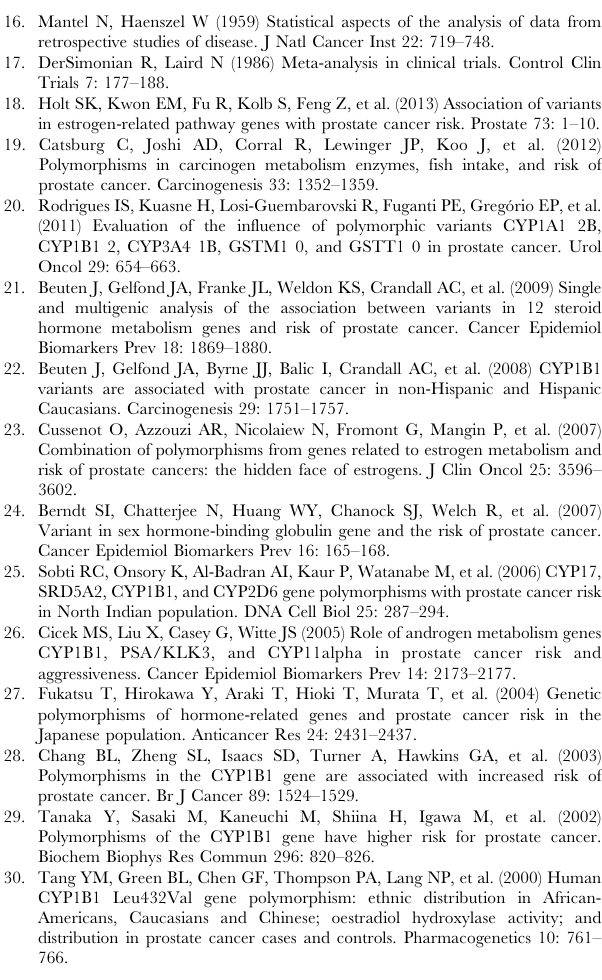
Figure S6 Funnel plots for publication bias for all population in recessive model (R48G: GG versus CC + GC). Figure S7 Funnel plots for publication bias for all population in dominant model (R48G: GG + GC versus CC). Figure S8 Funnel plots for publication bias for all population in allelic model (R48G: G versus C).